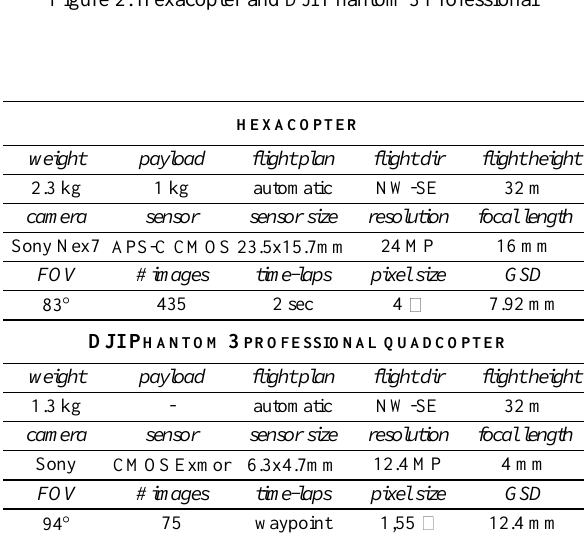
Figure 1. Case study: the Roman Amphitheatre in Avella